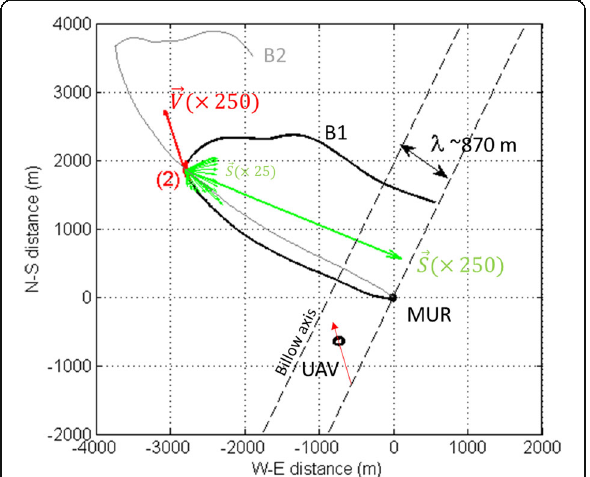
Fig. 1 a (Top) Time-height plot of MU radar echo power at vertical incidence and high-range resolution from 05:40 to 06:50 LT on 7 June 2015 corresponding to UAV4 and B1. The red (green) line shows the altitude (distance) of UAV4 vs. time. The blue line shows the altitude of B1 vs. time. The label 1 refers to cloud region, 2 to the KH region, and 3 to the stratified region, respectively. These 3 regions are separated by horizontal black lines at 1.80 and 2.15 km, for clarity. See the text for more details. b As in Fig. 1,a but for UAV5 and B2. c (Top) Time-height plot of the vertical velocity measured by MU radar from 05:40 to 06:40 LT on 7 June 2015 during the flight of UAV4. (Center) The corresponding time-height plot of Doppler variance corrected for beam broadening measured at vertical incidence. (Bottom) Aspect ratio defined as the difference (in decibel) between the vertical echo power and the average of the five oblique echo powers. Superimposed are isolines of echo power (Fig. 1a) for P MU = 10 dB showing the edges of the KH braids and the top of the cloudy cells. The horizontal solid lines delineate the KH region (2). The black or red curves show the altitude of UAV4 vs time, as in Fig. 1.a. d As Fig. 1c, but for the radar observations during UAV5